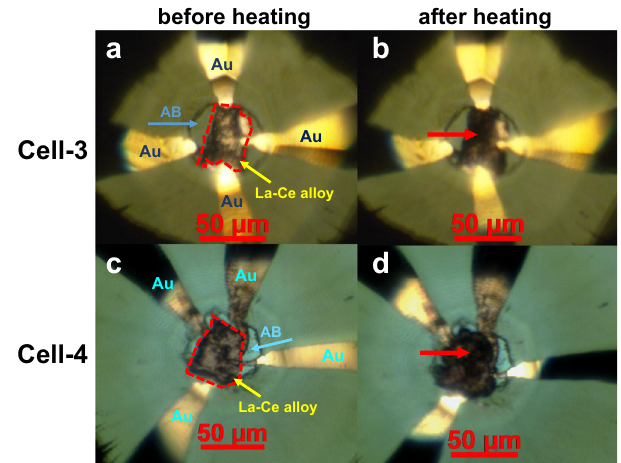
Fig. 1 | Optical micrographs of the sample chambers containing NH 3 BH 3 (AB) andAuelectrodesinCell-3andCell-4beforeandafterlaserheating.a and b are photos of Cell-3 before and after laser heating, respectively. c and d are photos of Cell-4 before and after laser heating, respectively. The edges of La-Ce alloys are marked with red dotted lines, and the red arrows point to the parts with apparent changes after the